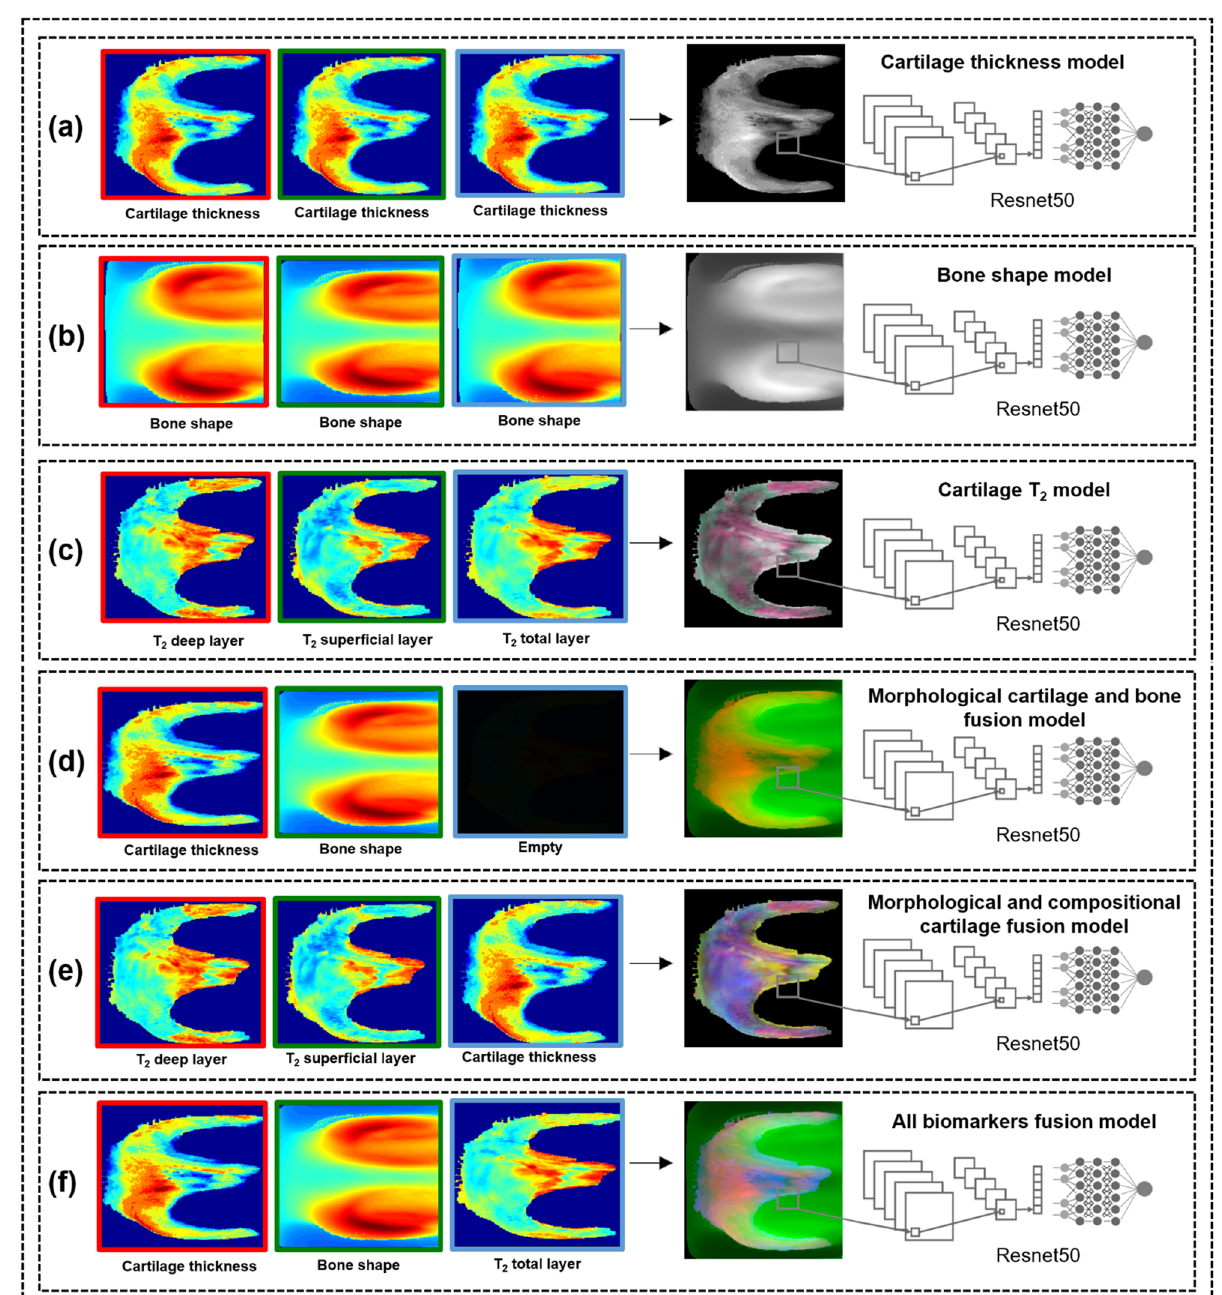
Figure 4. Overview of the biomarker model strategies, shown for the femur. The normalized spherical images for each patient were merged into a three-channel 8-bit image. (a–c) The first three strategies consisted of the single biomarkers: cartilage thickness, bone shape, and cartilage T 2 . (a) The cartilage thickness strategy consisted of the cartilage thickness spherical maps replicated three times into a spherical image. (b) The bone shape strategy consisted of the bone shape spherical maps replicated three times into a spherical image. (c) The cartilage T 2 strategy consisted of the deep, superficial, and average T 2 spherical maps as the first, second, and third channels respectively. (d–f) The last three fusion strategies consisted of the biomarker fusions: morphological cartilage and bone fusion, morphological and compositional cartilage fusion and all biomarkers fusion. (d) The morphological cartilage and bone fusion consisted of the cartilage thickness and bone shape spherical maps as the first and second channels respectively, with the last channel empty. (e) The morphological and compositional cartilage fusion consisted of the deep and superficial T 2 spherical maps as the first and second channels respectively with the third channel consisting of the cartilage thickness spherical map. (f) The all biomarkers fusion consisted of the cartilage thickness, bone shape, and average T 2 spherical map as the first, second and third channels